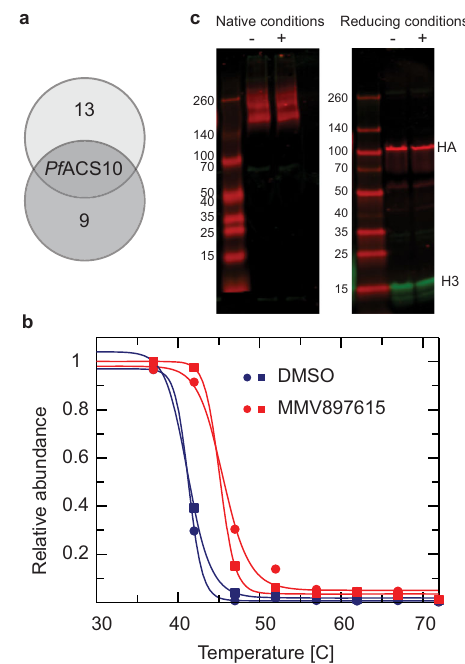
Fig.6|Thermalproteinpro fi ling(TPP)con fi rms Pf ACS10astheprimarytarget ofMMV897615.a Venndiagramofproteinsdisplayingthemostsigni fi cantthermal shifts in the presence of MMV897615 from duplicate experiments (biological replicates). b Melt curve for Pf ACS10 following incubation with 500nM MMV897615 or vehicle (0.1% DMSO) in the two independent experiments. The meanshiftinmeltingtemperature( Δ T m )for Pf ACS10was4.13°C.Datafromthetwo independent duplicate experiment are presented in Supplementary Data 5. c Wes- tern blot showing protein lysate of ACS11 cKD parasites cultured in the presence of 500nM aTc. Protein lysates was either exposed to 10mM MMV665924 and MMV019719 each (+),or control DMSO ( − ) for 30min at room temperature to test foreffectof MMV665924and MMV019719 on protein stability. Lysates wereeither run on a non-denaturing gel or on a SDS gel, transferred to a membrane, and detected with anti HA antibodies. No effect of MMV665924 and MMV019719 on dimerizationcouldbedetected.SourcedataareprovidedasaSourceData fi le.aTc